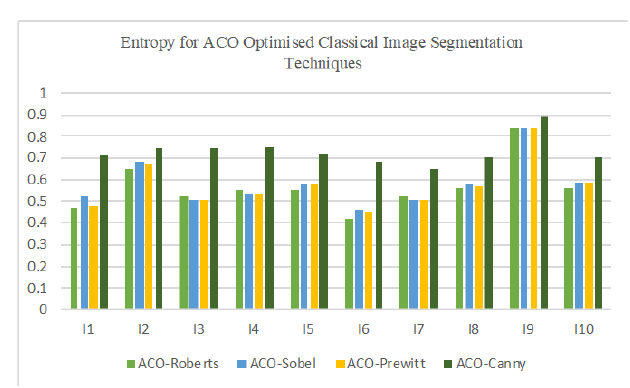
Figure 13. Entropy for ACO Optimised Classical Image Segmentation Techniques